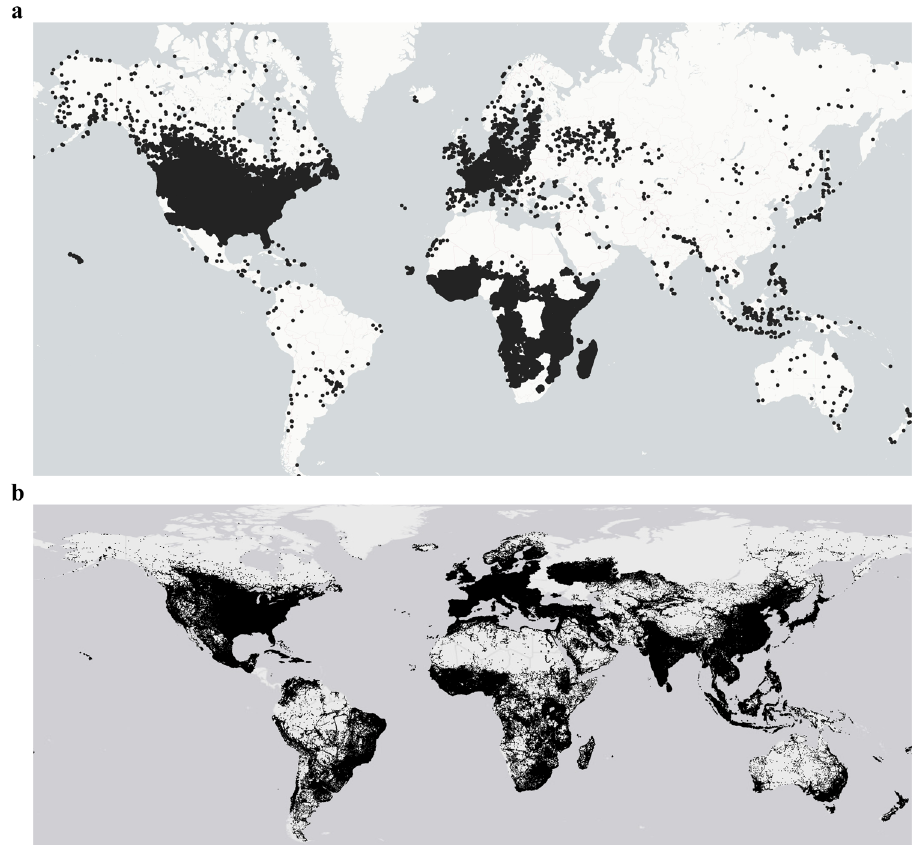
Fig. 3 Geographical distribution of global roads and sample Fishnet cells. a Global distribution of sample FN was generated in our study. Microsoft AI- based building polygons are used for the USA, Canada, and Tanzania, Ecopia AI-derived building footprint areas are used for the African countries. OSM- derived building polygons representing a total of 4000 sample FNs are used for the rest of the world. b Geographic location of all the global roads used in our analysis. OSM-derived global roads have near-global coverage, with each pixel on the map being for each road feature inside the country of reference. Data Credits: Fig. 3b, © OpenStreetMap